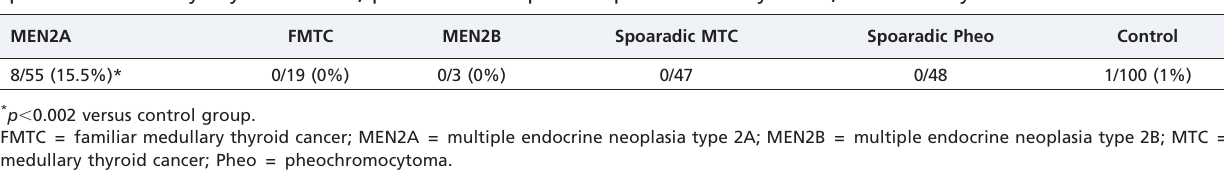
Table 1 - Prevalence of the G12S polymorphism of the SDHD gene among germline RET mutation carriers, patients with sporadic medullary thyroid cancer, patients with sporadic pheochromocytomas, and healthy